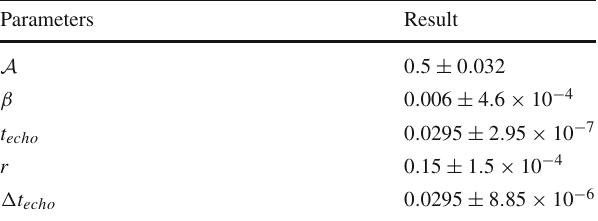
Table 3 The summary of UIE parameter estimation with fisher infor- mation matrix. We use the simulation noise generate from Advanced LIGO [48], and the injected value can be found in Table 1